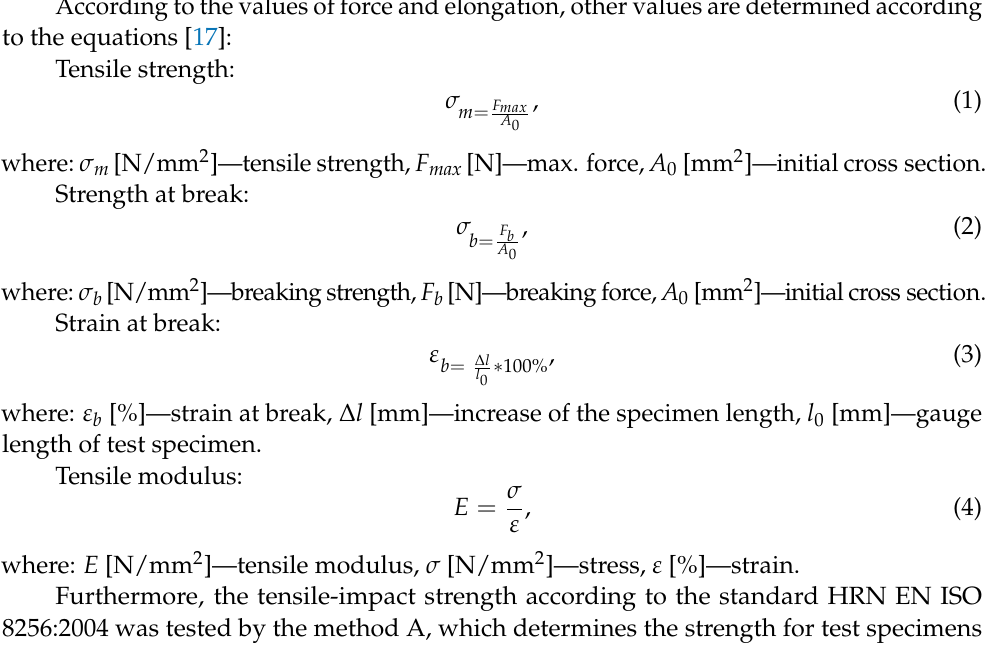
Figure 2. Test specimen for testing tensile properties [17].